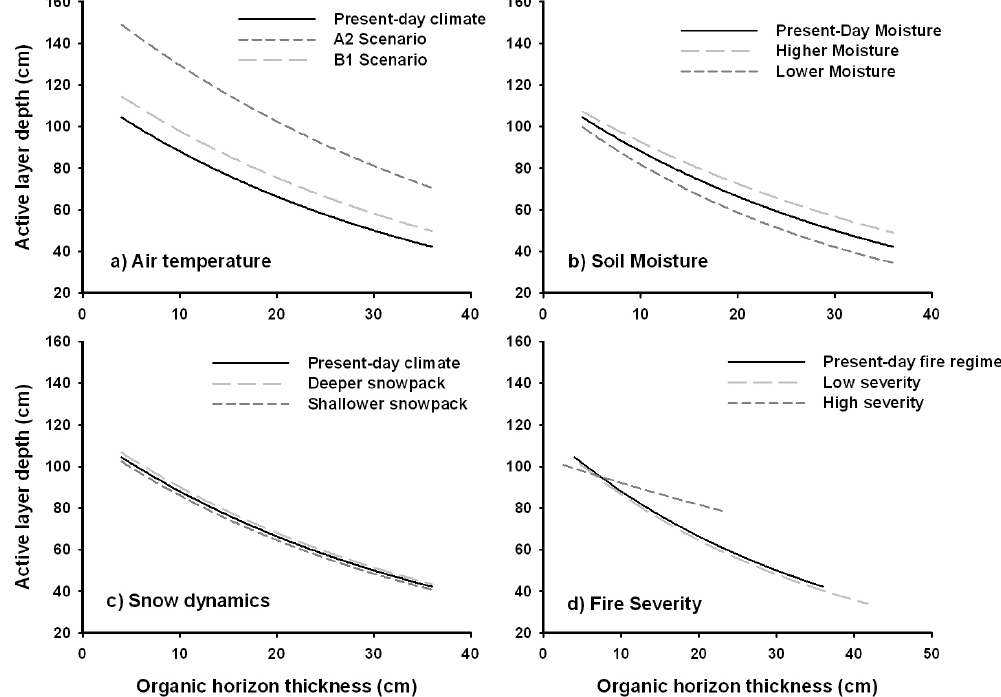
Fig. 4. Sensitivity of the active layer depth (ALD) to temperature, soil moisture, snow dynamics and fire severity. The relationship between ALD and organic horizon thickness was modeled using GIPL across a range of future air temperatures ( a ; IPCC scenarios), moisture conditions (b) , snow (c) , and fire severity (d) . Output data from each scenario were then fit with the exponential equation: ALD = a · e − b · OHT , where OHT is organic horizon thickness, and are summarized in Table 4. Equations were then used to run Fire-C model to evaluate sensitivity of soil carbon to various climate